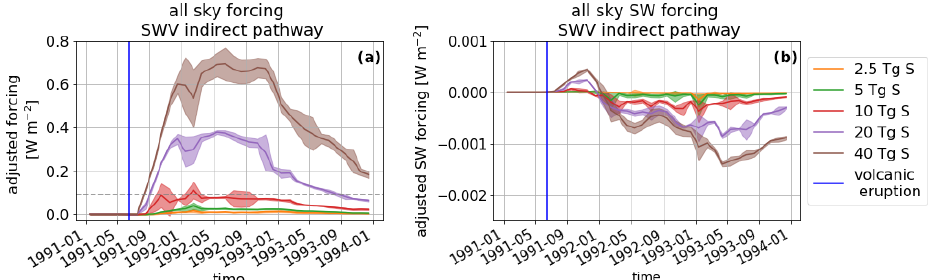
Figure E2. Time evolution of the (a) total and (b) SW component to the adjusted all-sky forcing in the tropical region at [− 5 , 5 ] ◦ latitude for the ensemble mean SWV increases caused by all eruption strengths. The blue line marks the eruption time. The flux range originating from the standard deviations of the SWV profiles is plotted to visualize the signal range.